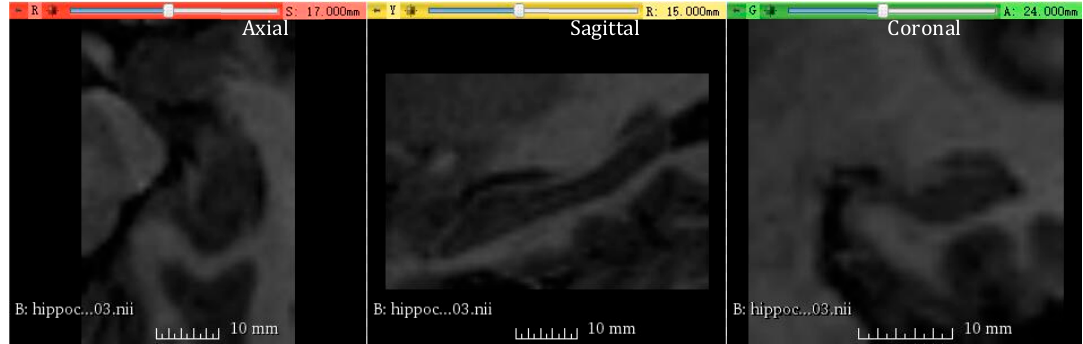
Figure 6. A sample of Hippocampus data shown in axial, sagittal, and coronal plane views from left to right. The axial view was chosen in this paper.